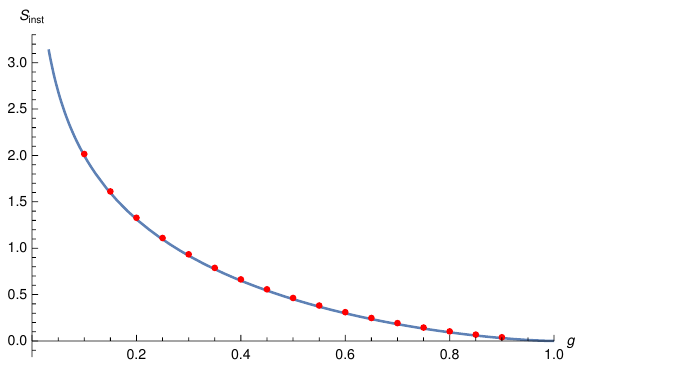
Figure 3. Plot of the instanton action S inst ( g ) in the range 0 < g < 1. The red dots are the numerical values extracted from the exact free energy using (2.16) with N = 400, while the solid curve represent the analytic form of S inst ( g ) in